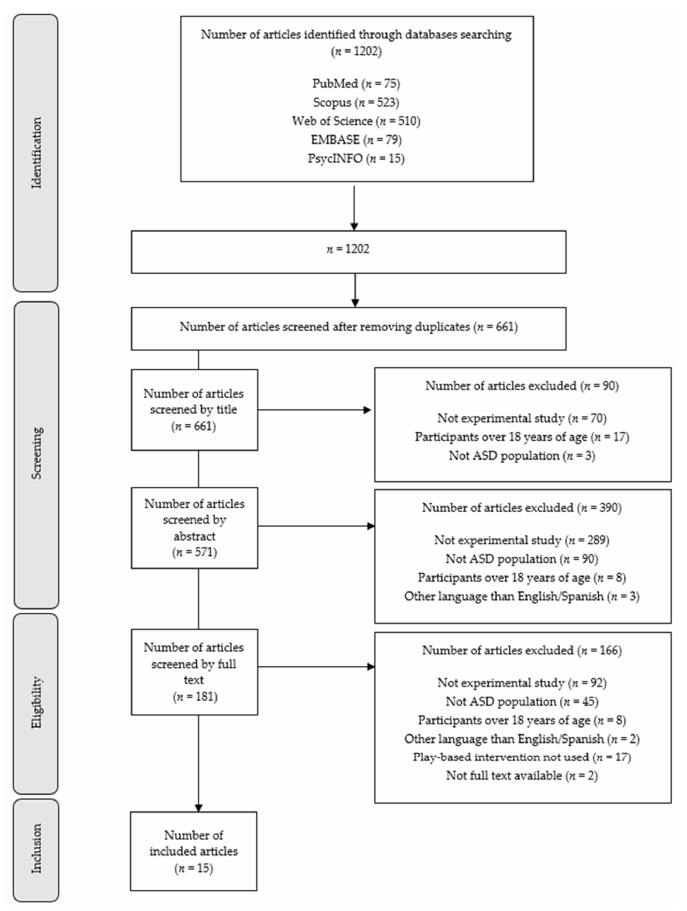
Figure 1. Flowchart of the study selection process.